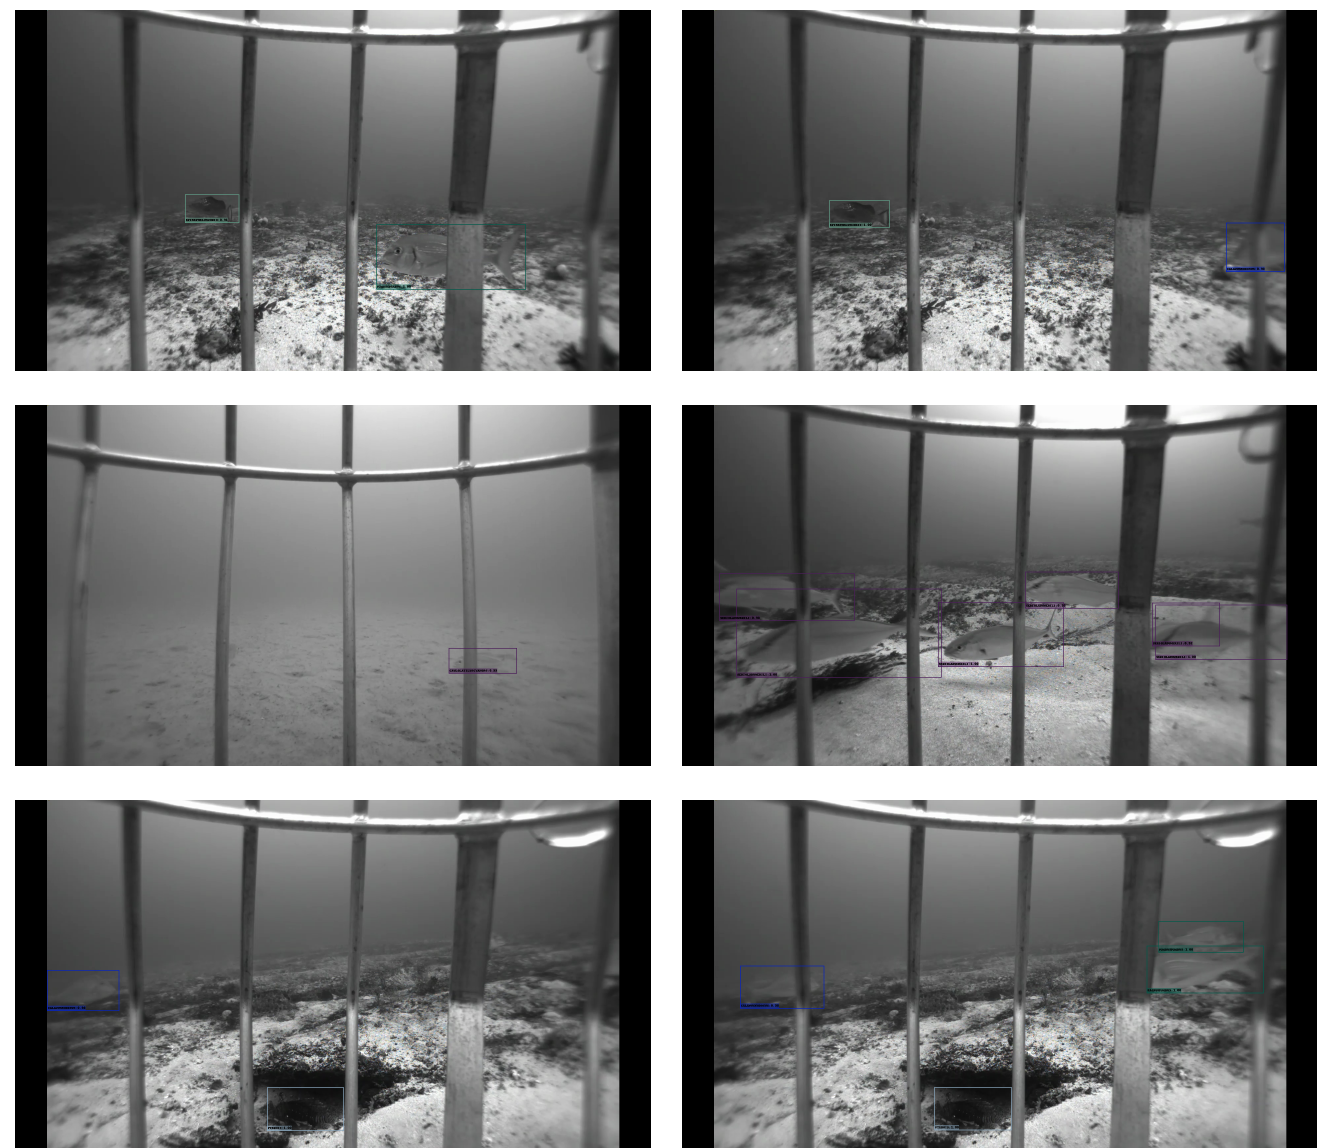
Figure 5. VGG300 backbone qualitative outputs. All fish species are detected in the sample images except the bottom left image. In the bottom left image, one fish is not detected, which is on the middle right side of the image. It is not easy to spot the missed fish, even for humans.